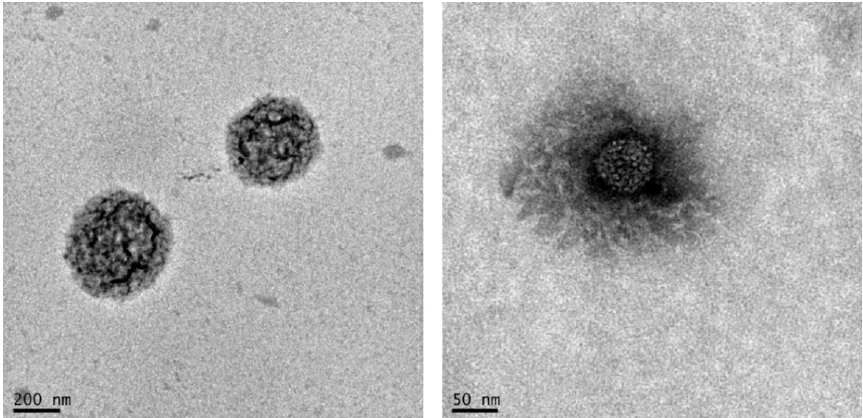
Figure 3. TEM images of blank (NG6B, on the left ) and berberine loaded (NG6L, on the right ) nanogels.